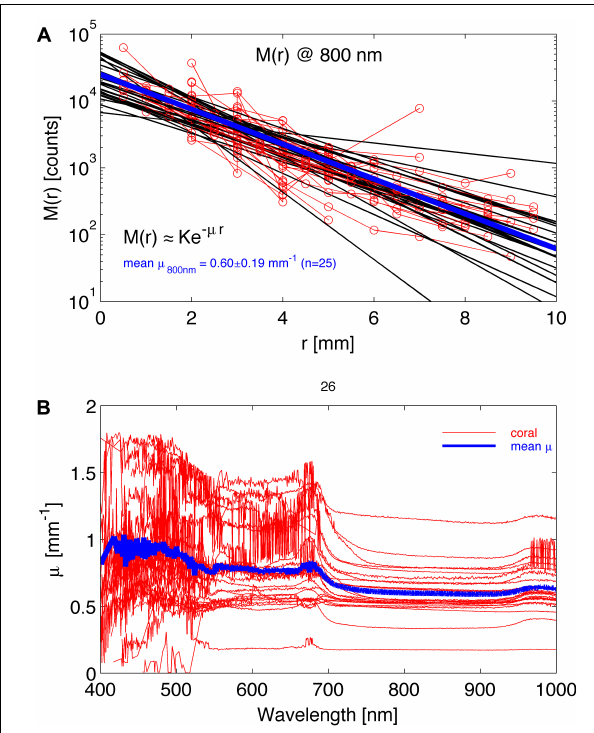
FIGURE 2 | Experimental determination of lateral light attenuation in corals. (A) M(r) data at 800 nm for 26 coral samples fitted with the exponential function M(r) = K · e − µ · r (black lines). Blue line is the average fit. (B) The lateral attenuation spectrum of µ versus wavelength for the 26 coral specimens. Blue line is average spectrum.